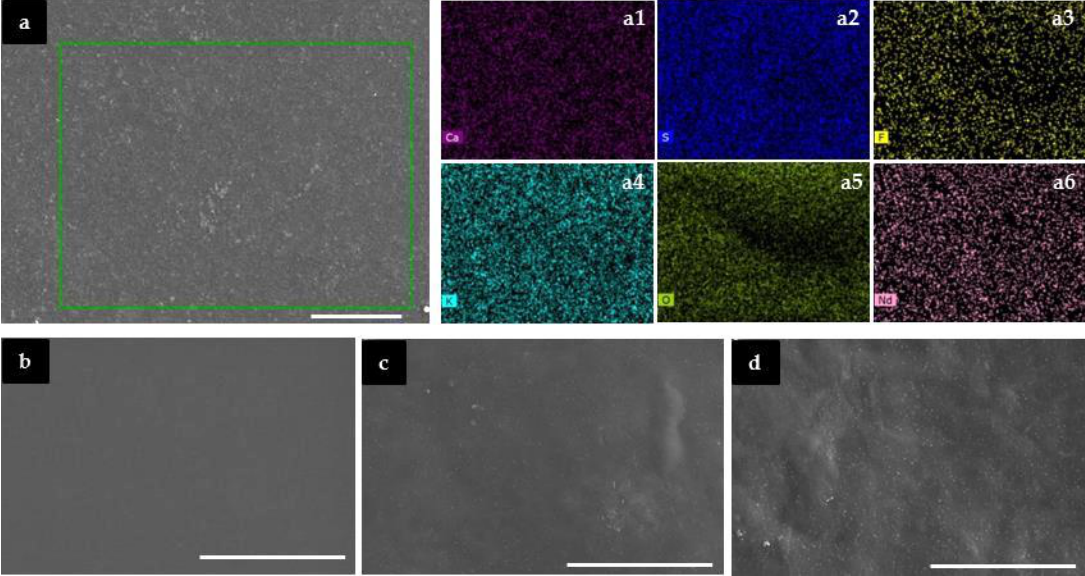
Figure 3. SEM images of the CG 50 Ndz membranes with z = 10% ( a ), 20% ( b ), 30% ( c ) and 40% ( d ). Scale bars = 50 µ m. a1 – a6 : EDS mapping of the inset region of a